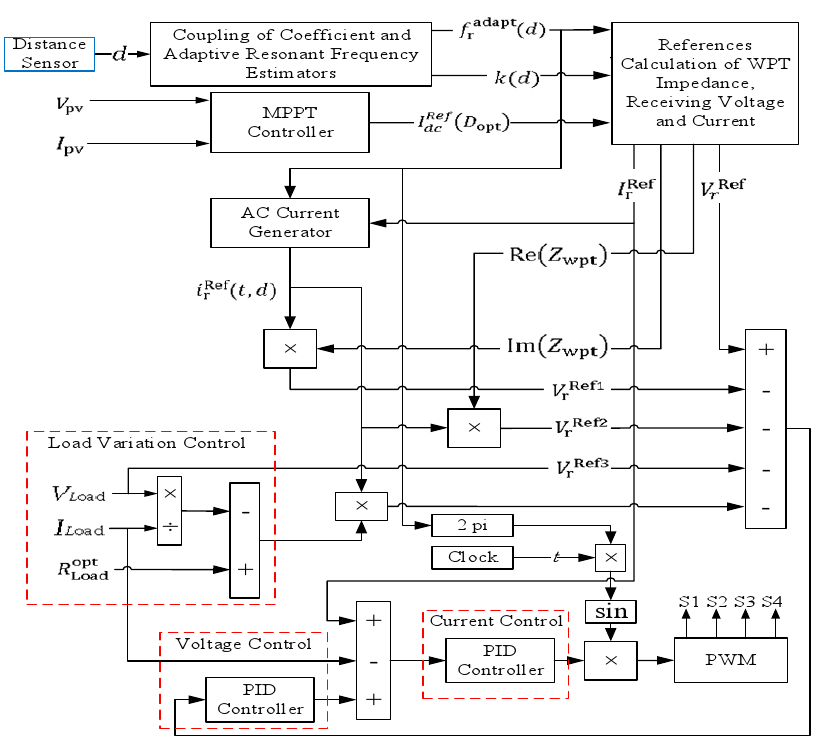
Figure 16. Adaptive virtual impedance controller.